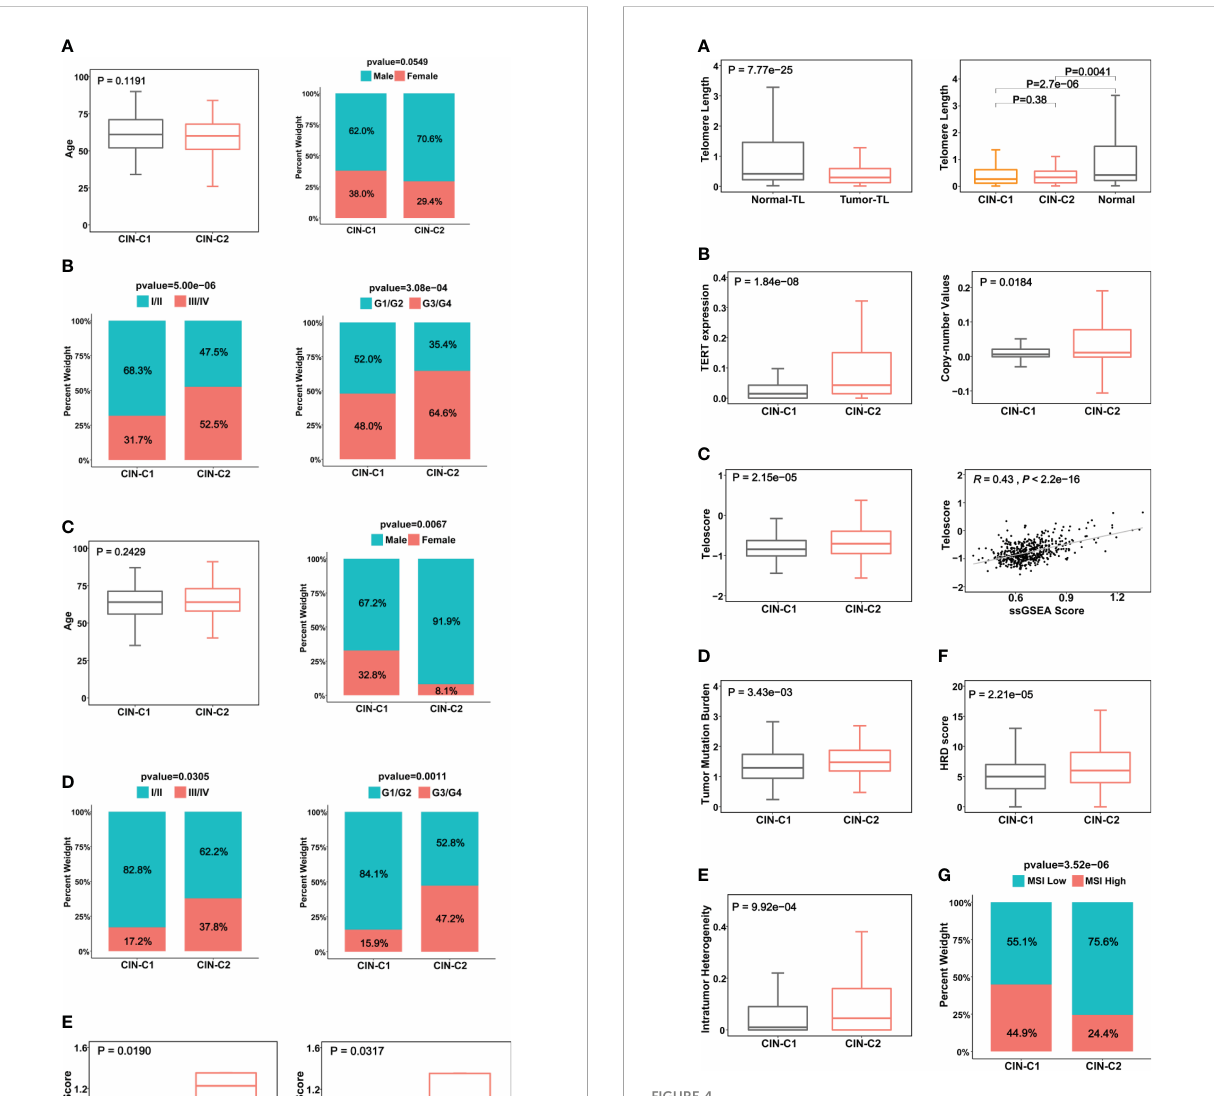
FIGURE 4 Association between CIN25 subtypes and telomere length, telomerase and other genomic alterations in ccRCCs. The TCGA cohort of ccRCCs were analyzed. Telomere length data were from reference 33. (A) Telomere shortening occurred in ccRCC tumors independently of CIN25 subtypes. Left panel: ccRCC tumors had signi fi cantly shorter telomeres than did renal nontumorous tissues (NTs). Right panel: Both CIN25-C1 and C2 tumors had similar telomere length, shorter than NTs. (B) Robustly higher TERT expression (left) and increased TERT copy numbers (right) in CIN25- C2 tumors. (C) Left panel: Signi fi cantly higher levels of telomerase activity, as assessed using the telomerase score in CIN25-C2 tumors. Right panel: The strong correlation between telomerase score and CIN25 ssGSEA score in ccRCC tumors. (D – G) CIN25-C2 tumors coupled with higher levels of other types of genomic instability. Higher tumor mutation burden (TMB) (D) , intratumoral heterogeneity (ITH) (E) , homologous recombination de fi ciency (HRD) (F) and microsatellite instability (MSI) (G) in CIN25-C2 tumors.